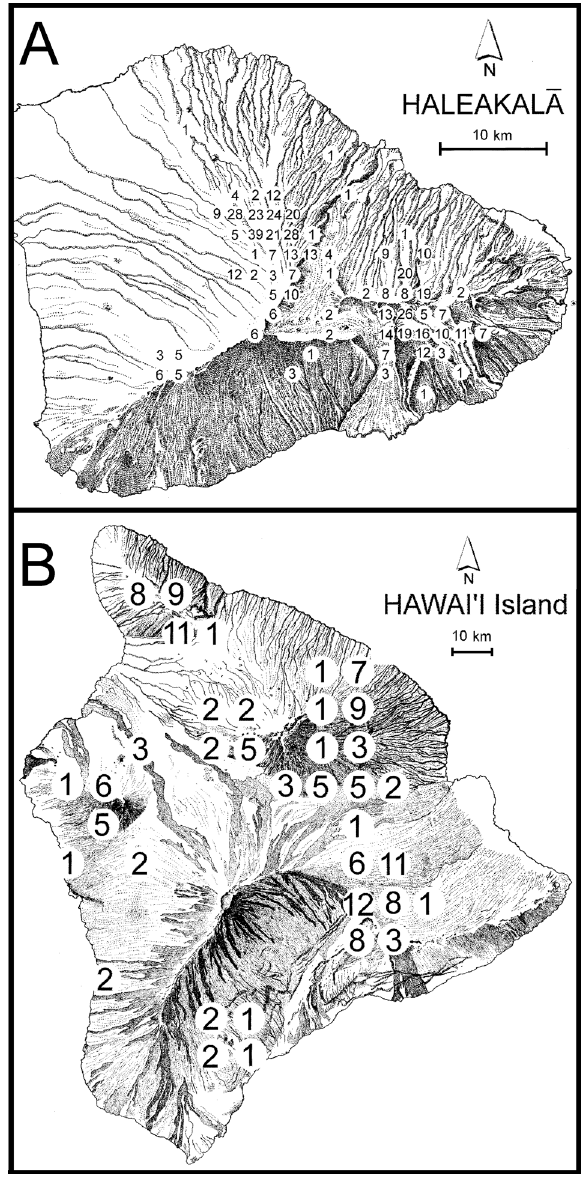
Figure 28. Number of Mecyclothorax spp. present in latitude × longitude quadrats for two Hawaiian Islands: A , Haleakalā vol - cano, Maui (area 1450 km 2 ) with species recorded within 1´ × 1´ cells; B , Hawaiˋi Island (10,432 km 2 ) with species recorded within 5´ × 5´ cells. A total of 116 species of Mecyclothorax are known to occur on Haleakalā (Liebherr 2015), and 30 species are known from Hawaiˋi Island (Liebherr